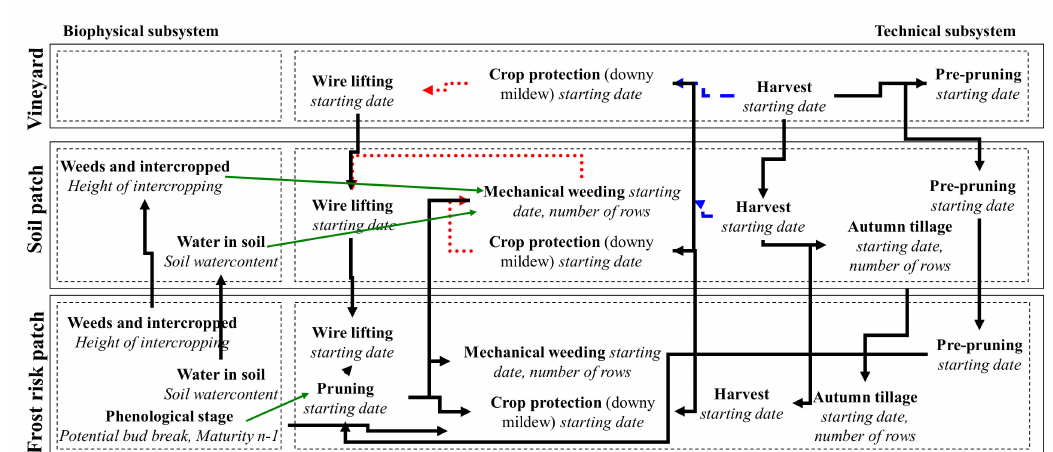
Figure 4. Figure 4 shows the hierarchical breakdown of the technical and biophysical subsystems on the three first levels of organization at the end of Step 6. The interactions between the two subsystems are represented for the three first levels in the hierarchy. Each interaction could be associated with a rule linking a value or the state of the biophysical variable. Finally, Figure 4 shows also the establishment of horizontal and vertical interactions among the technical subsystem and the biophysical subsystem for the three first levels. Each arrow represents an interaction (which can be described by a decision rule) between two crop management practices: continuous thin arrow = start; thin dotted arrow = report; long dotted arrow = stop; continuous thick arrow =